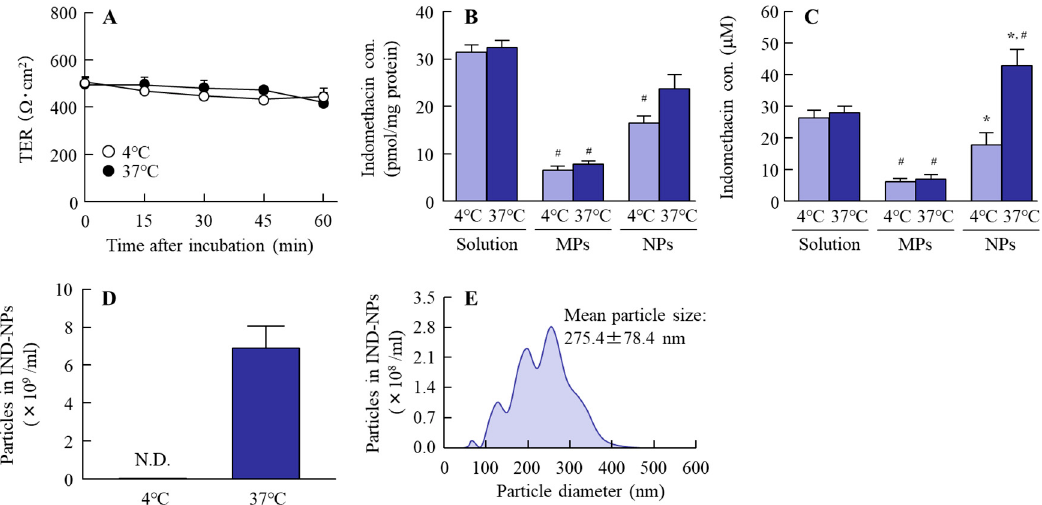
Figure 3. Penetration of indomethacin in IND-NPs at 4 and 37 ◦ C through Caco-2 cell monolayers. ( A ) Changes in transepithelial electrical resistance (TER) of Caco-2 cell monolayers treated with IND-NPs. ( B , C ) Accumulation ( B ) and penetration ( C ) of indomethacin through Caco-2 cell monolayers treated with IND-solutions, IND-MPs, and IND-NPs. ( D , F ) Number ( D ) and size frequencies ( E ) of indomethacin nanoparticles in the basolateral side under at 4 ◦ C. n = 6. * P < 0.05 vs. 37 ◦ C for each category. # P < 0.05 vs. IND-solution at 37 ◦ C. The accumulation and penetration of indomethacin nanoparticles were significantly decreased at 4 ◦